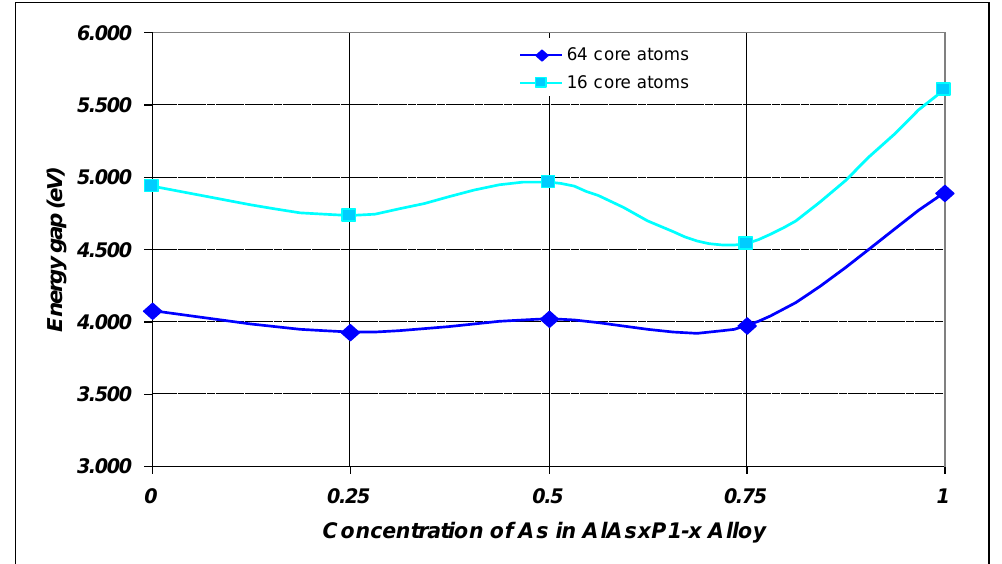
Fig. 6: Energy gap of Al As for 16 and 64 core atoms per LUC.